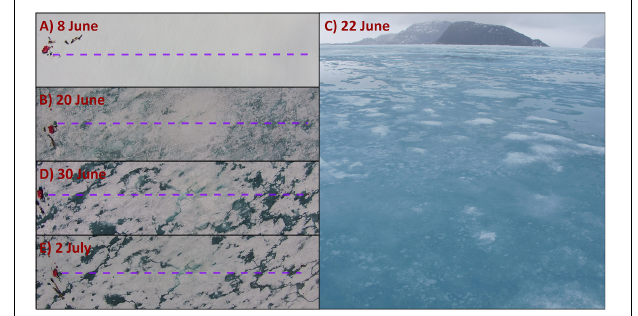
FIGURE 3 | Areal images of sea ice surface conditions along the sampling transects on (A) 8 June, (B) 20 June, (C) 22 June, (D) 30 June, and (E) 2 July, 2016. The ROV under-ice ND transect is indicated by the purple dashed